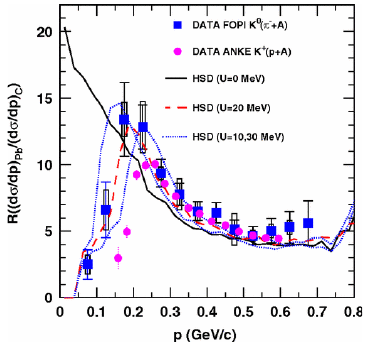
Figure 1. Ratio of inclusive K 0 ( K + ) cross-sections produced by pions (protons) impinging on heavy and light targets as a function of the kaon momentum [3]. The full squares depict the ratio of K 0 produced on Pb and C targets s measured by FOPI at an beam momentum of 1.15 GeV / c . While, the full circles show the ratio of K + produced on Au and C targets measured by ANKE in proton-induced